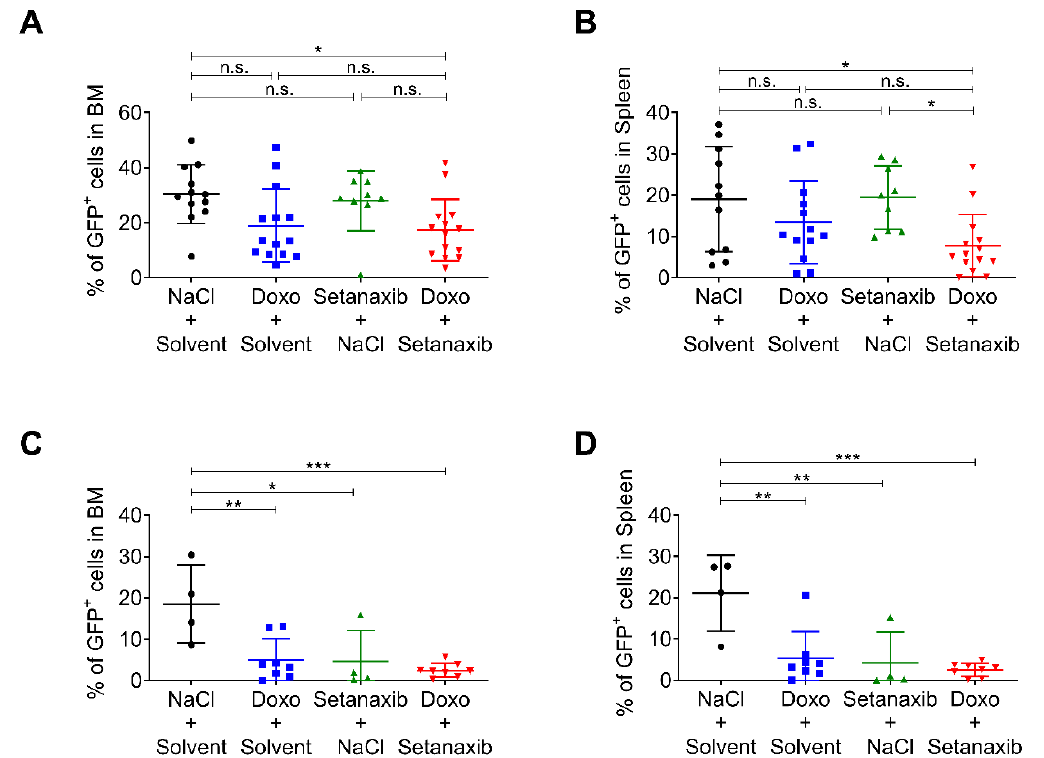
Figure 3. Effect of single and combined drug treatments with Setanaxib and doxorubicin in vivo. ( A , B ) 2 × 10 6 GFP-expressing 32D FLT3-ITD cells were injected in C3H/HeJ mice via the tail vein, and respective drug treatments were applied. Setanaxib was given at 40mg/kg body weight by daily gavage for 9 days, and doxorubicin at 3mg/kg body weight by i.p. injection at day 3, 4, and 5 post-transplantation. Mice in independent experiments (two cohorts) were sacrificed 9- or 10-days post-transplantation. The percentage of GFP-positive cells was determined by flow cytometry in ( A ) BM and ( B ) spleen. ( B , C ) 5 × 10 5 GFP-expressing 32D FLT3-ITD cells were injected in C3H/HeJ mice and respective drug treatments were applied as in ( A , B ). Mice in independent experiments (two cohorts) were sacrificed 10 days post-transplantation. The percentage of GFP-positive cells was determined by flow cytometry in ( C ) BM and ( D ) spleen ( n = 4–8 per group, mean ± SD). Statistical analyses were carried out using one-way ANOVA with Tukey ´ s post-test. (n.s.—not significant, * p < 0.05, ** p < 0.01, and *** p <